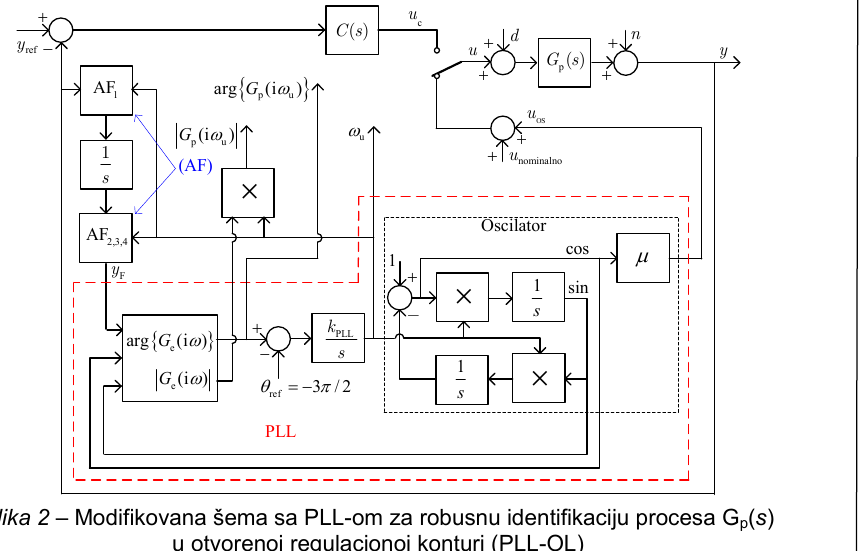
Figure 2 – Modified PLL open-loop (PLL-OL) structure used for a robust identification of the process G p ( s